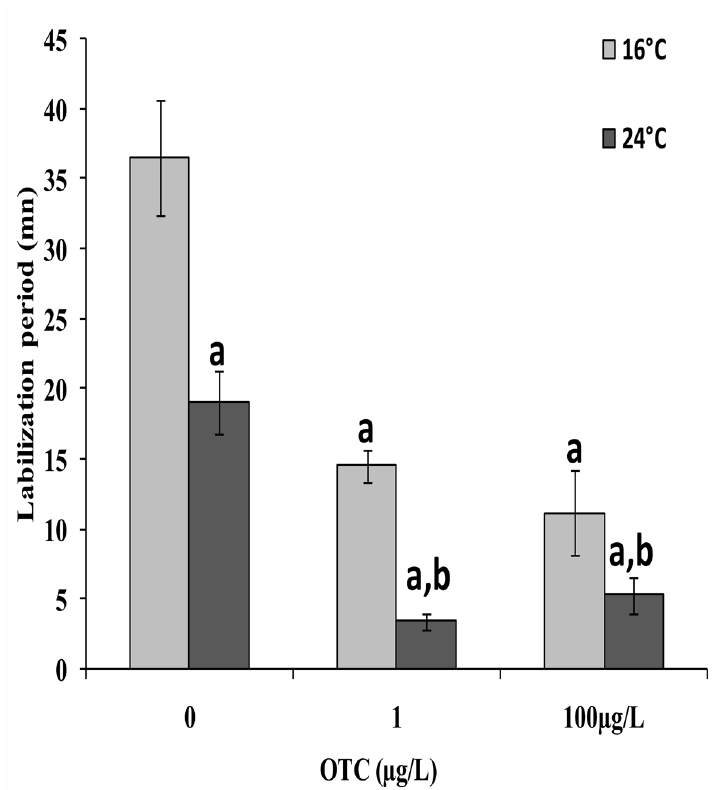
Fig 1. Lysosomal membrane stability (LMS) in digestive gland sections of M . galloprovincialis individuals after a 4-day treatment with 1 or 100 μ gtetracycline at 16° and 24°C. Data are expressed as the Labialization period in mn are represent the mean ± Sd (N = 4). (a: significantly different from reference condition. b: significantly different from OTC-untreated mussels at 24°C (p < 0.05).